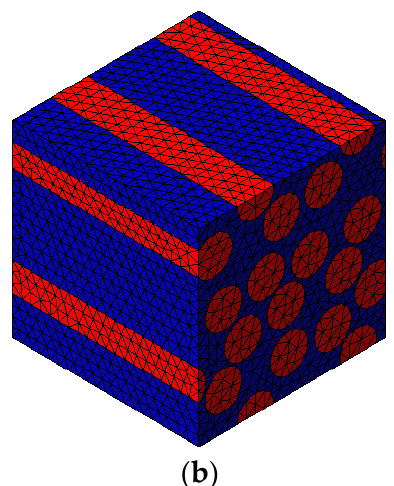
Figure 6. RVE geometry for aligned oriented fiber ( a ), and their tetrahedral mesh ( b ).